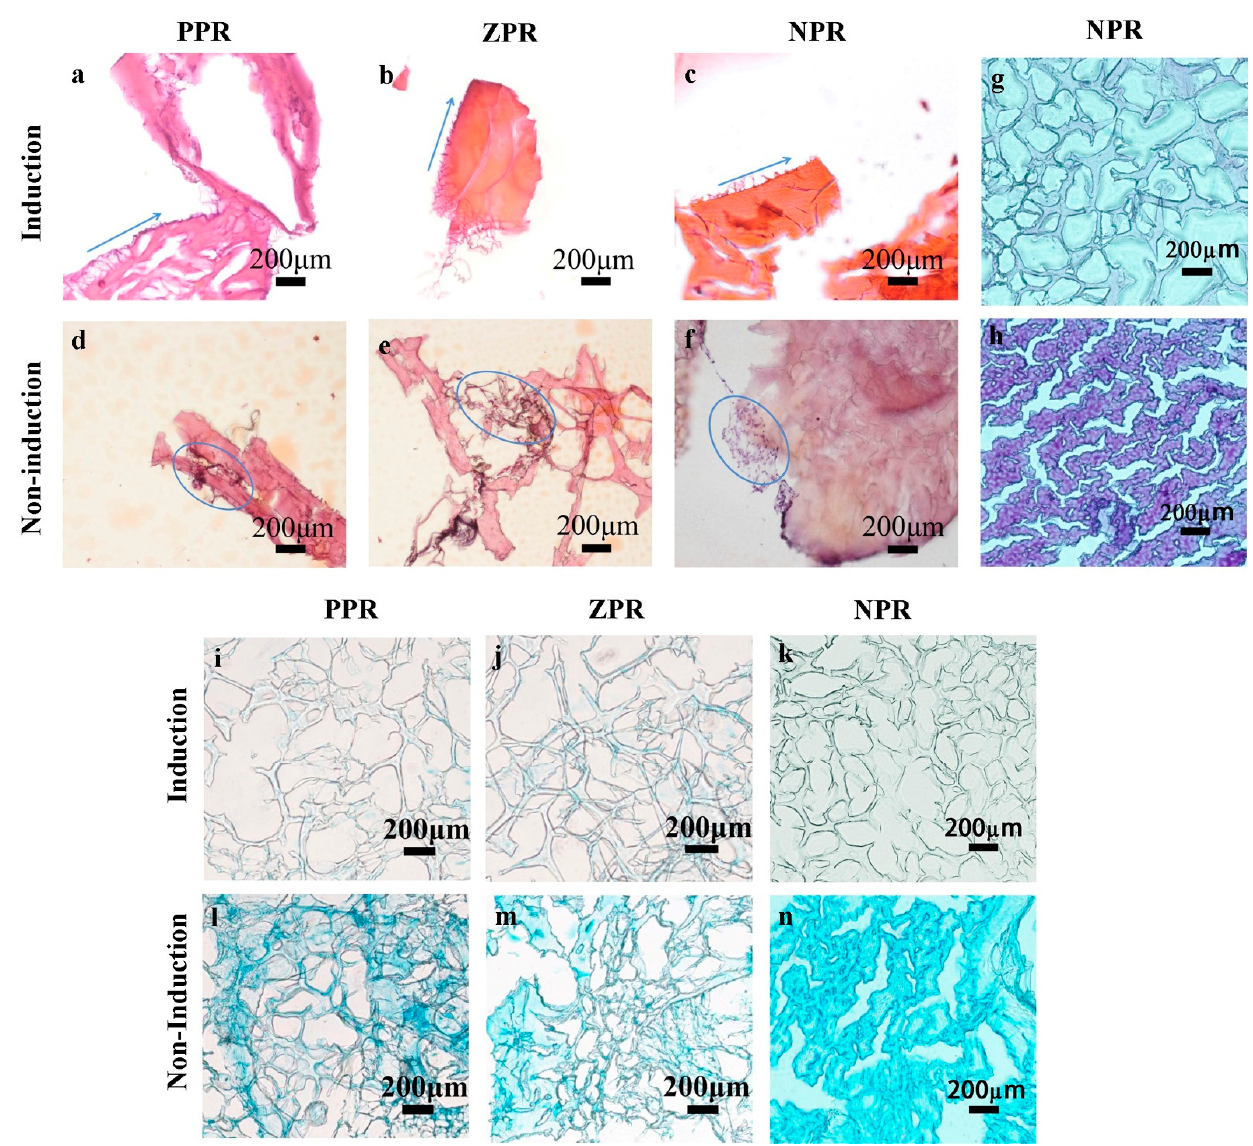
Figure 6. ( a –f) Hematoxylin and eosin (HE) staining of mBMSCs induced on different Poisson’s ratio CNFs/PEGDA scaffolds for 3 weeks. ( g – n ) Staining of cartilage matrix of mBMSCs after 2 weeks of non ‐ induction and induction on the NPR CNFs/PEGDA scaffolds. ( g – h ) Toluidine blue staining of mBMSCs; ( i – n ) Alcian blue staining of mBMSCs.